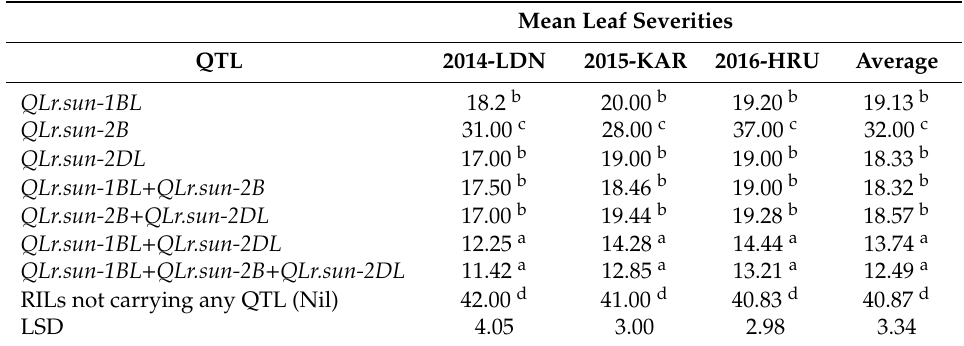
Table 2. Mean leaf rust severities of Aus27506 / Aus27229 RILs carrying di ff erent QTL